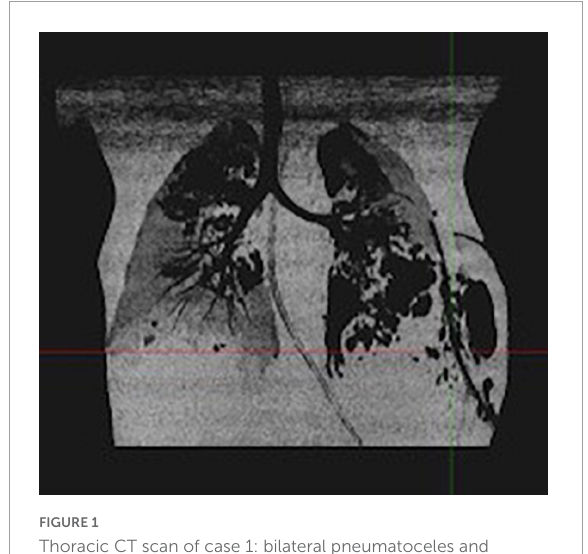
FIGURE1 Thoracic CT scan of case 1: bilateral pneumatoceles and necrotizing pneumonia.